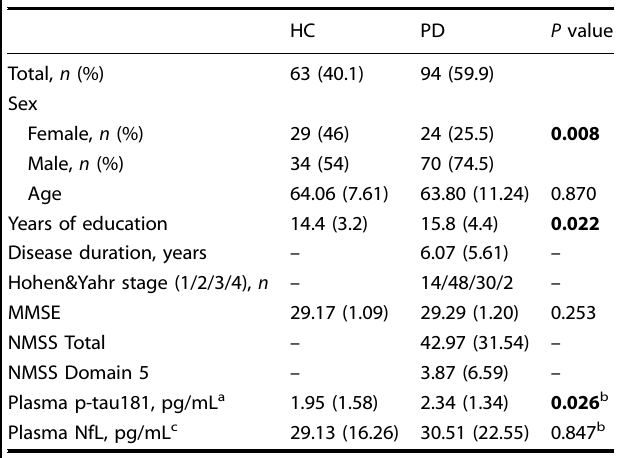
Table 1. Baseline characteristics of the